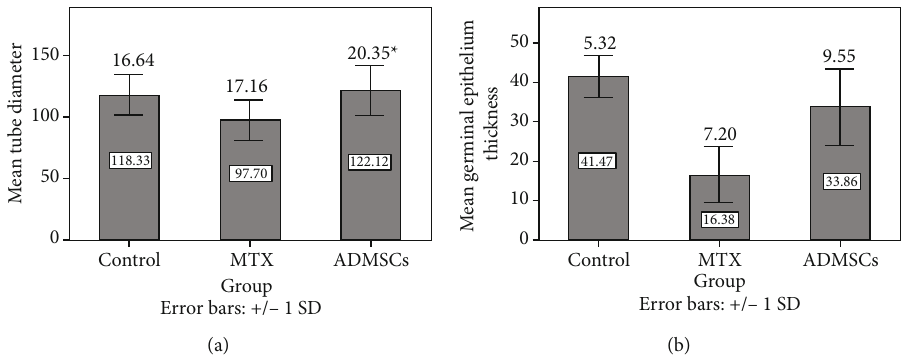
Figure 2: (a) The mean outer diameter of the seminiferous tubules; q indicates a signi fi cant di ff erence between MTX and control groups. ∗ indicates a signi fi cant di ff erence between MTX- and ADMSC-treated groups. (b) The mean germinal epithelium thickness using the post hoc Tukey test. The mean di ff erence is signi fi cant at the 0.05 level, and a statistically signi fi cant di ff erence between all groups is